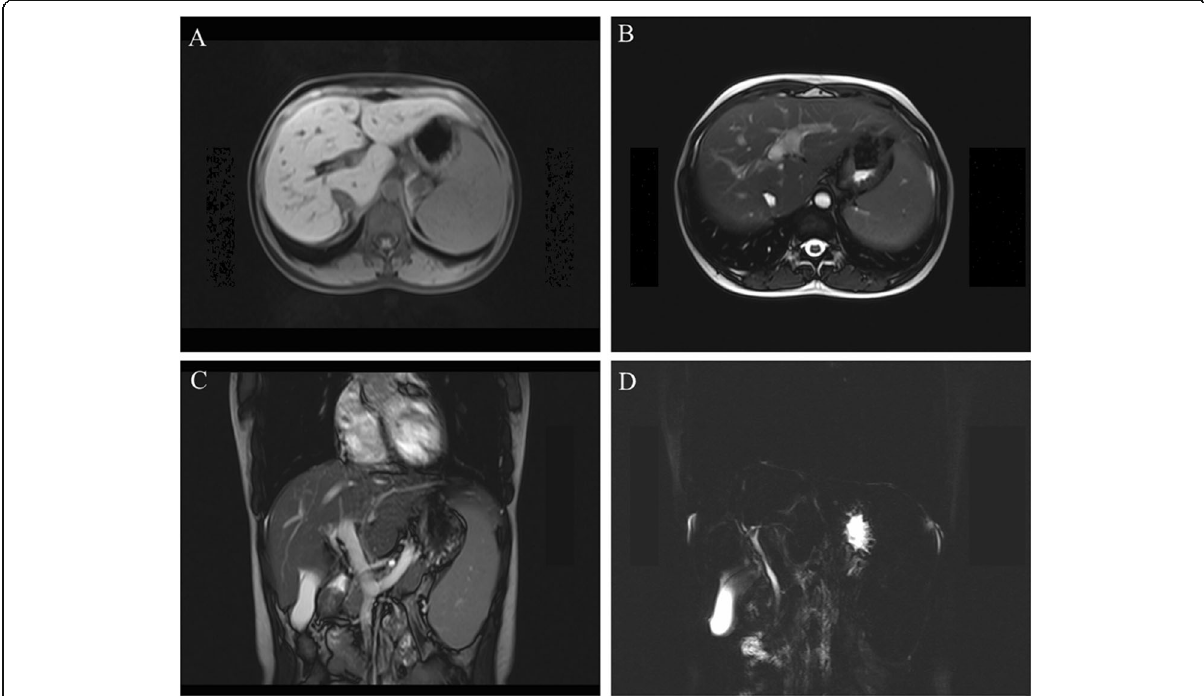
Fig. 1 Liver magnetic resonance image. The abdominal magnetic resonance image shows liver cirrhosis, portal hypertension, splenomegaly, and cholestasis. No obstruction of the intrahepatic and extrahepatic bile ducts was found after further magnetic resonance cholangiopancreatographic examination